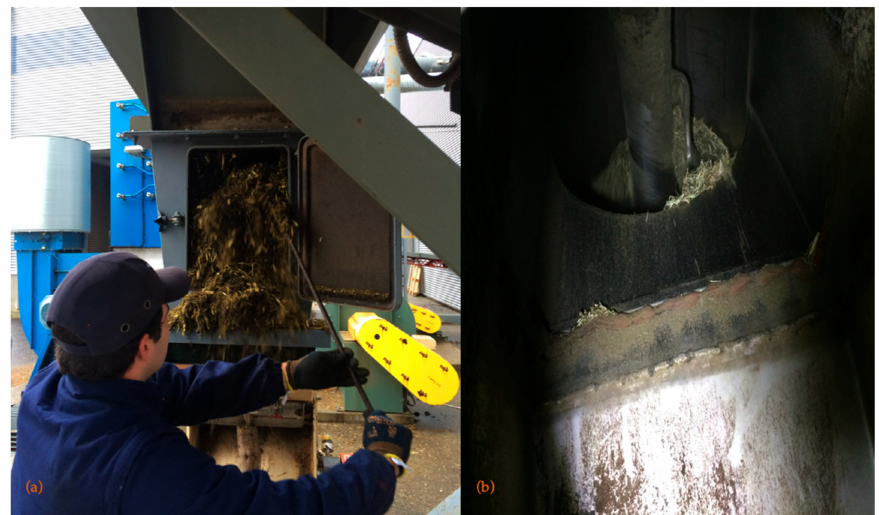
Figure 5. ( a ) Clogging caused by low density and shape coefficient occurred in the transition between the self-feeder (system feed point) and the first hammer mill; ( b ) the accumulation of material inside the auger caused the propeller to warp, forcing it to stop for